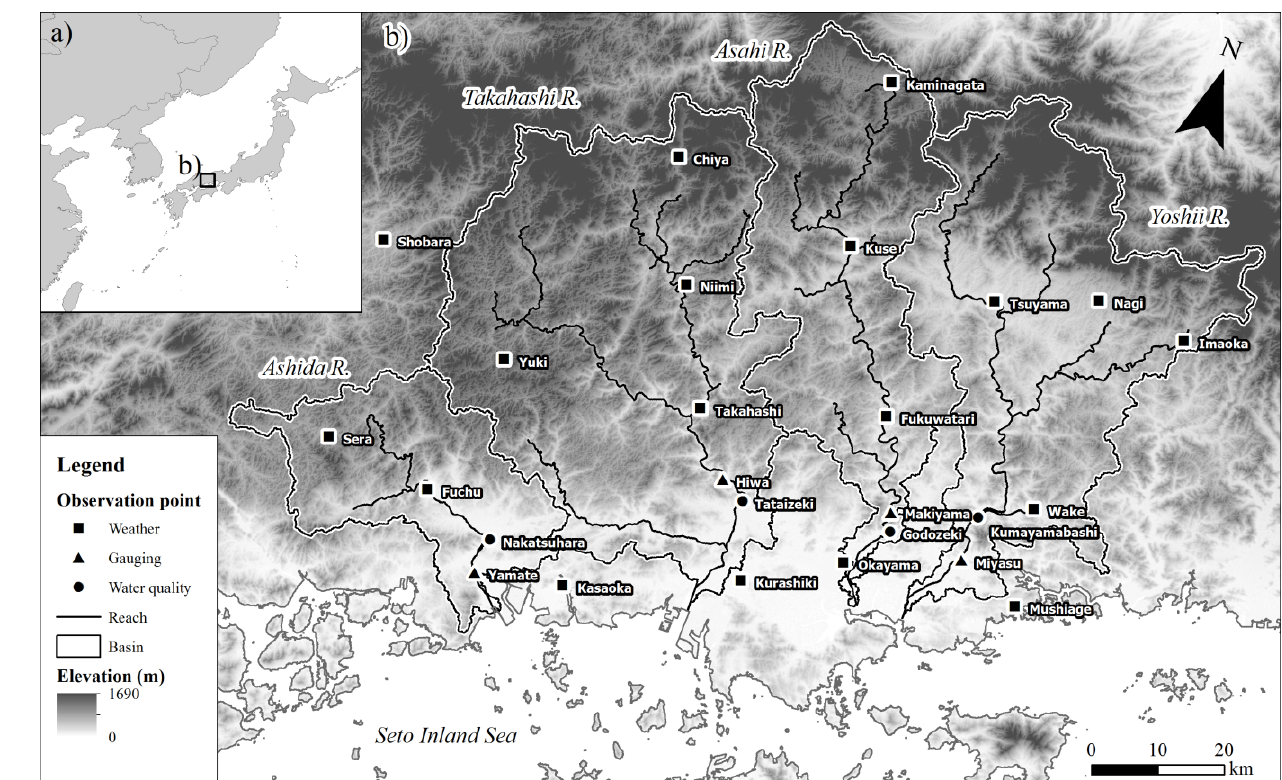
Figure 1. Location of the study watersheds (a) and observed monitoring stations (b) .